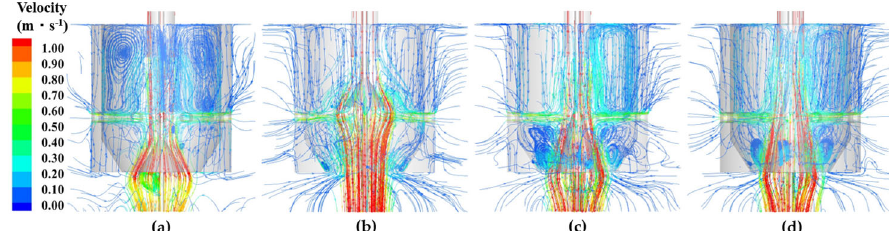
Figure 10. Internal flow-field distribution and velocity characteristics of the feedwell: ( a ) α a = 60 ◦ ; ( b ) α b = 60 ◦ , with the bottom height of the conical deflector of ( b ) being 1766 mm higher than that of ( a ); ( c ) α c = 30 ◦ ; and ( d ) α d = 21.1 ◦ .